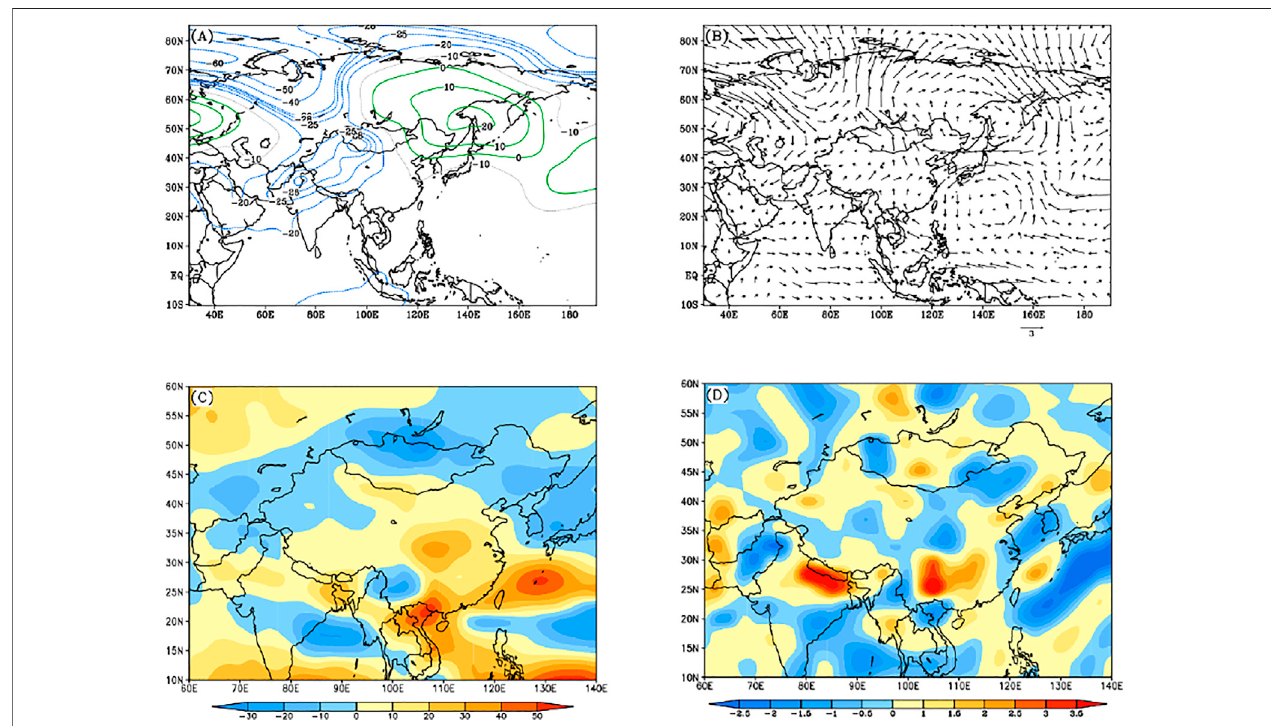
FIGURE 8 | Difference in (A) geopotential height, (B) wind at 500 hPa, (C) vertically integrated water vapor fl ux (surface to 300 hPa), and (D) vertically integrated water vapor fl ux divergence (surface to 300 hPa) during the year with the highest concentration of extreme precipitation.